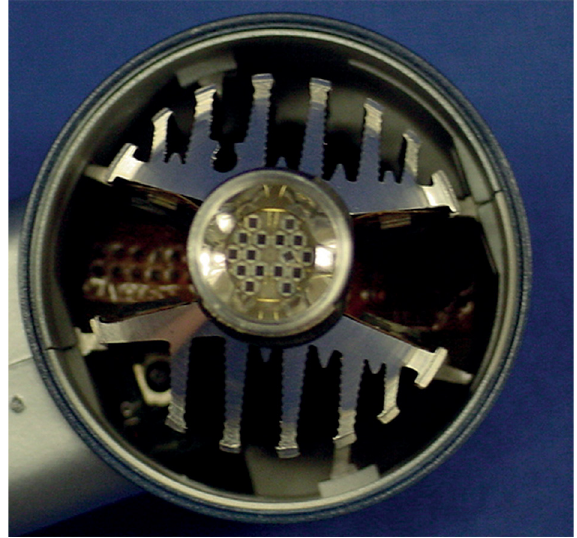
Figure 23. Individual LED can-type emitters closely packed into an array of a first-generation dental LED curing light.